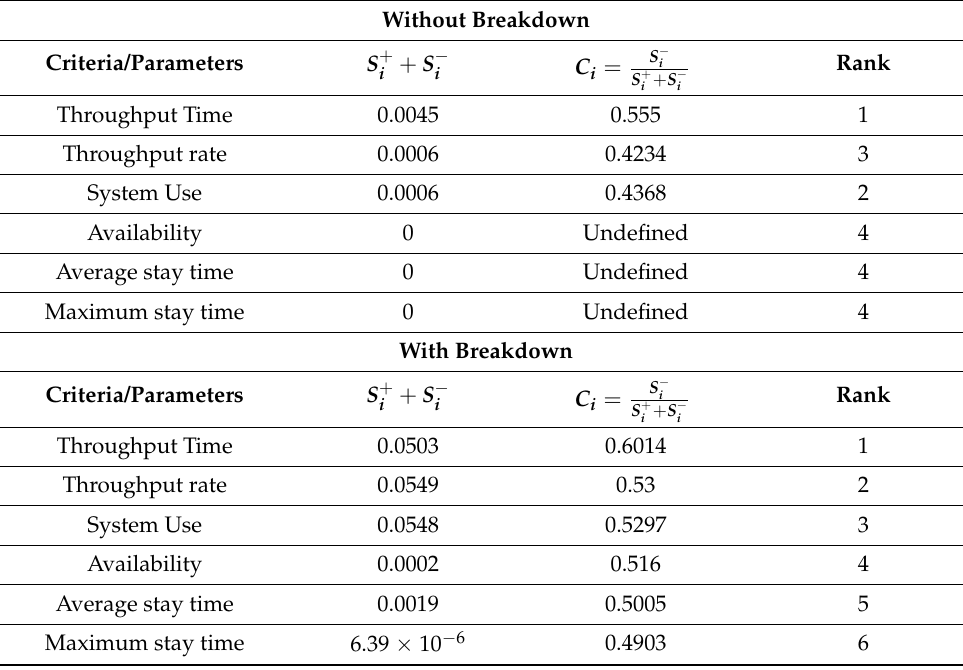
Table 16. Matrix of relative closeness and ranking of the parameters. Without